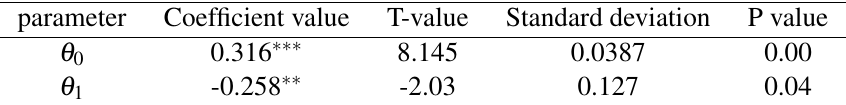
Table 2 Estimated Results of Equation